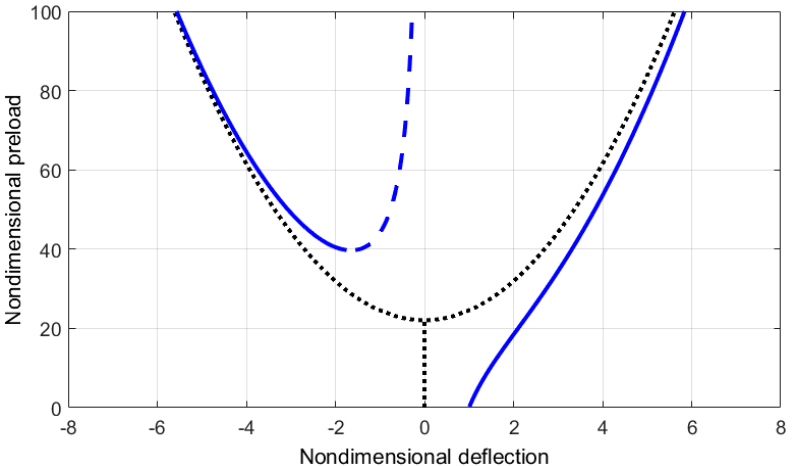
Figure 5. Variation of the static deflection with the pre-load at 𝑎 = 1,𝜇̅ = 0.02 , and 𝛼 = 1 .